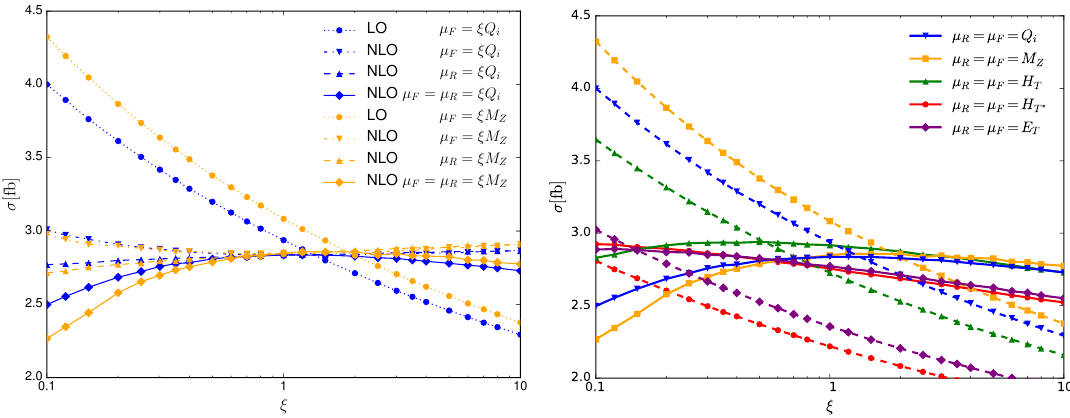
Figure 2 . Left: dependence of the total cross section on the variation of the factorization and renormalization scale, as well as the combined variation. Results are shown using the central scales Q i and M Z . Right: combined variation of the two scales for di(cid:11)erent choices of the central value. The last cut in eq. (3.2) eliminates the singularity arising from a virtual photon, (cid:13) (cid:3) ! ‘ + ‘ (cid:0) . Additionally, we impose the typical VBF cuts on the tagging